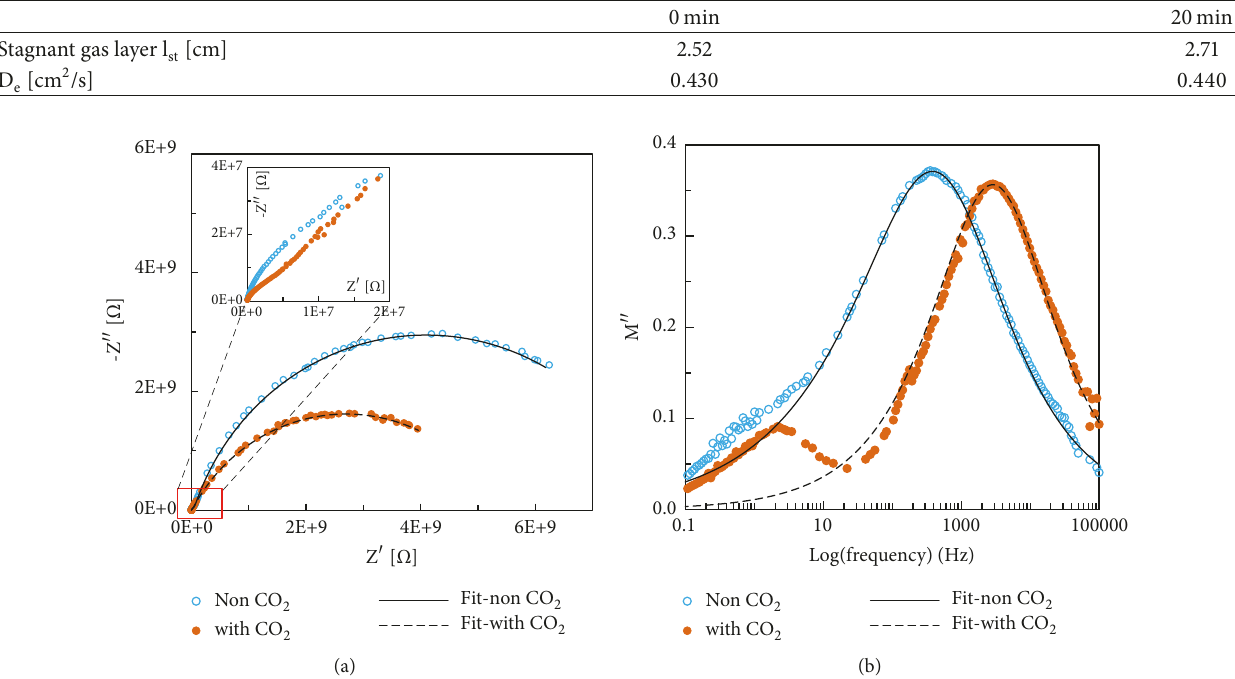
Figure 5: (a) Nyquist plot and (b) modulus loss M 󸀠󸀠 of Z5A-1 with and without loading CO 2 at 433